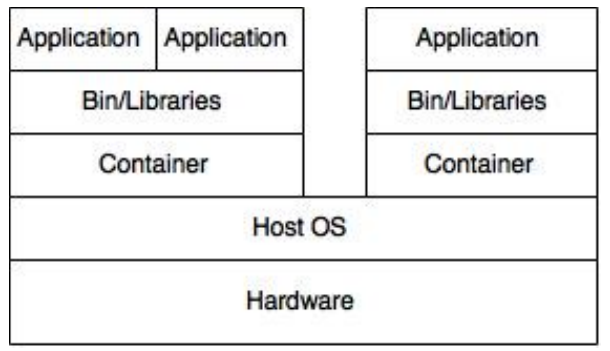
Figure 5. Two containers sharing one OS.